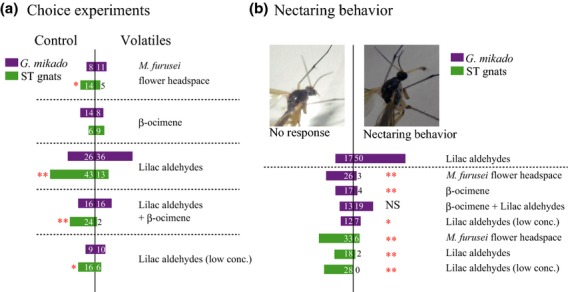
Contrasting reactions observed in the pollinators. (a) Lilac aldehydes and floral headspace of Mitella furusei were avoided only by short-tongued (ST) gnats (the numbers of choices are shown adjacent to the bars). One-tailed binomial test, *P < 0.05, **P < 0.001. (b) Only lilac aldehydes presented to Gnoriste mikado at high concentration induced typical nectaring behaviour (above the dashed line) more frequently than others (the numbers of responses are shown adjacent to the bars). Fisher's exact test, *P < 0.05, **P < 0.001.